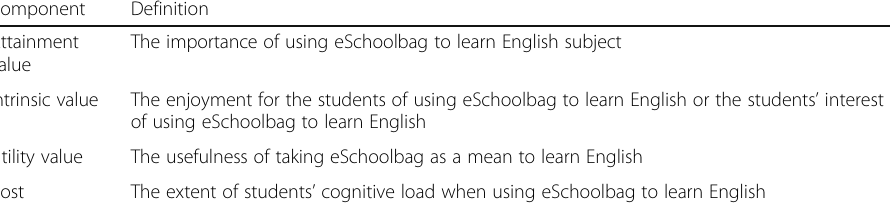
Table 1 Motivational Model of Using eSchoolbag to Learn English